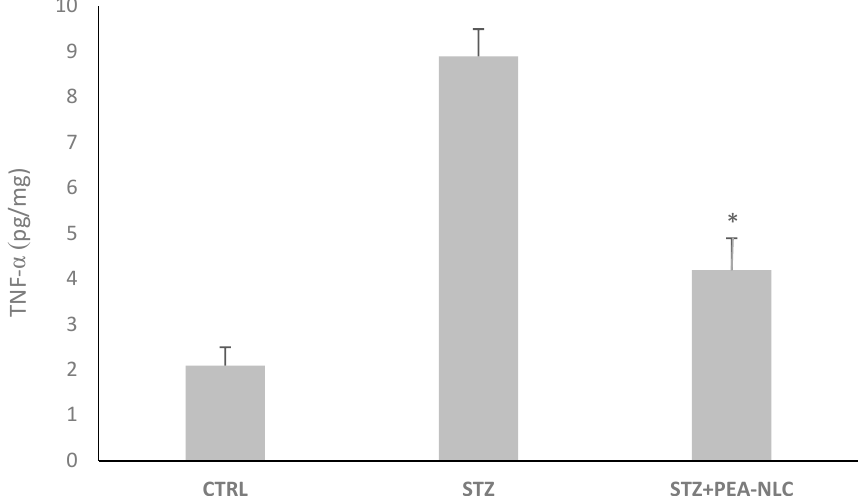
Figure 4. Retinal levels of TNF- α 10 days after STZ injection. Data shown are expressed as the mean ± SD. * p < 0.05 vs. STZ. n = 12 .